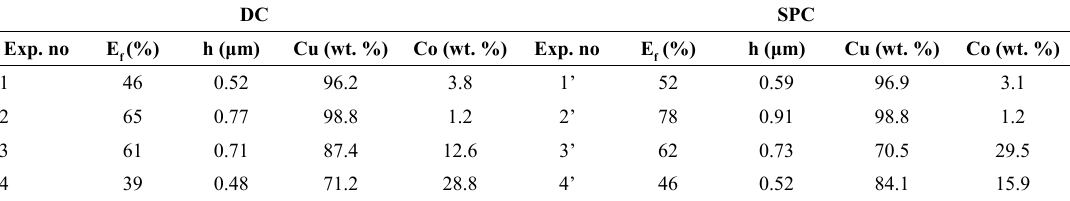
Table 3. Average values of current efficiency (E coatings produced at different j (or jm) values (Table 1), using DC and SPC.